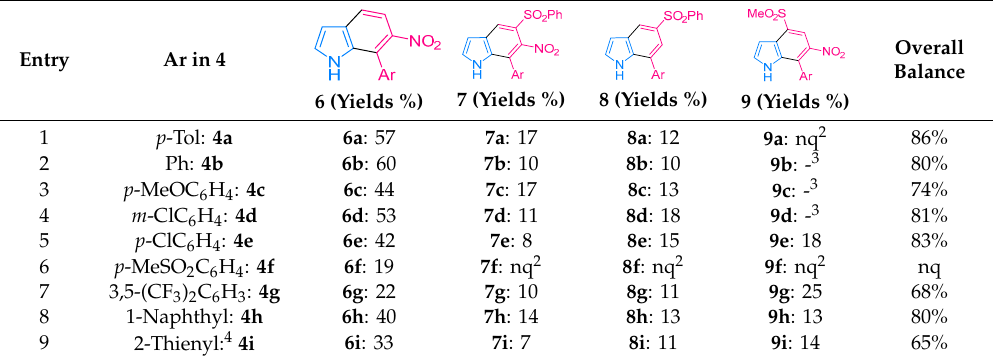
Table 2. Results obtained in the reactions of nitrobutadienes 4a – i with pyrrole in TFE at 40 °C for 5 h 1 .